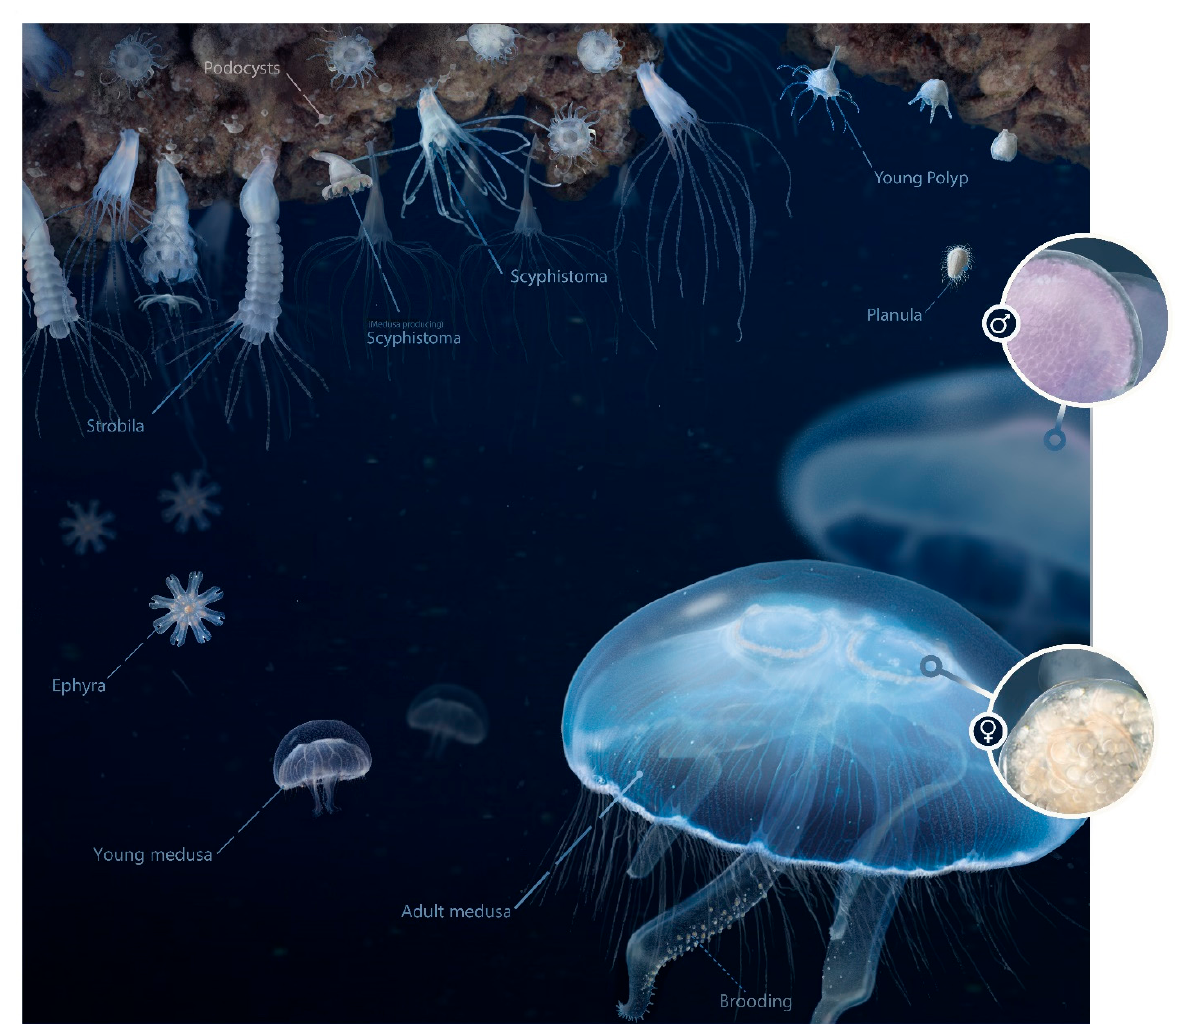
Figure 3. Metagenic life cycle of a scyphozoan jellyfish illustrated for the moon jelly Aurelia aurita . Planula larvae (upper right corner) are released from brood pouches of adult females (lower right corner) and settle on hard substrate, metamorphose into asexually reproducing polyps (scyphistoma), which release several small ephyrae via budding (upper left corner), but polyps can also form podocysts under unfavourable conditions. Ephyrae (left side) represent the new sexually reproducing pelagic life-stage with female and male medusae showing characteristic horseshoe gonad (four) structures, with female oocytes (opaque to brown/orange) and male spermatophores (pink). Note: Under special conditions, one scyphistoma can shortly after settlement metamorphose directly into one ephyra (direct development). Image credit: N. Bezio.